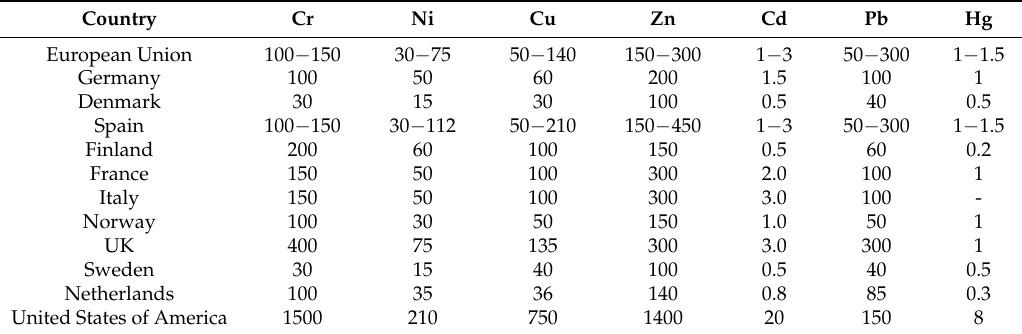
Table 1. Maximum metal concentration allowed in soils treated with sewage sludge in different countries (mg/kg)